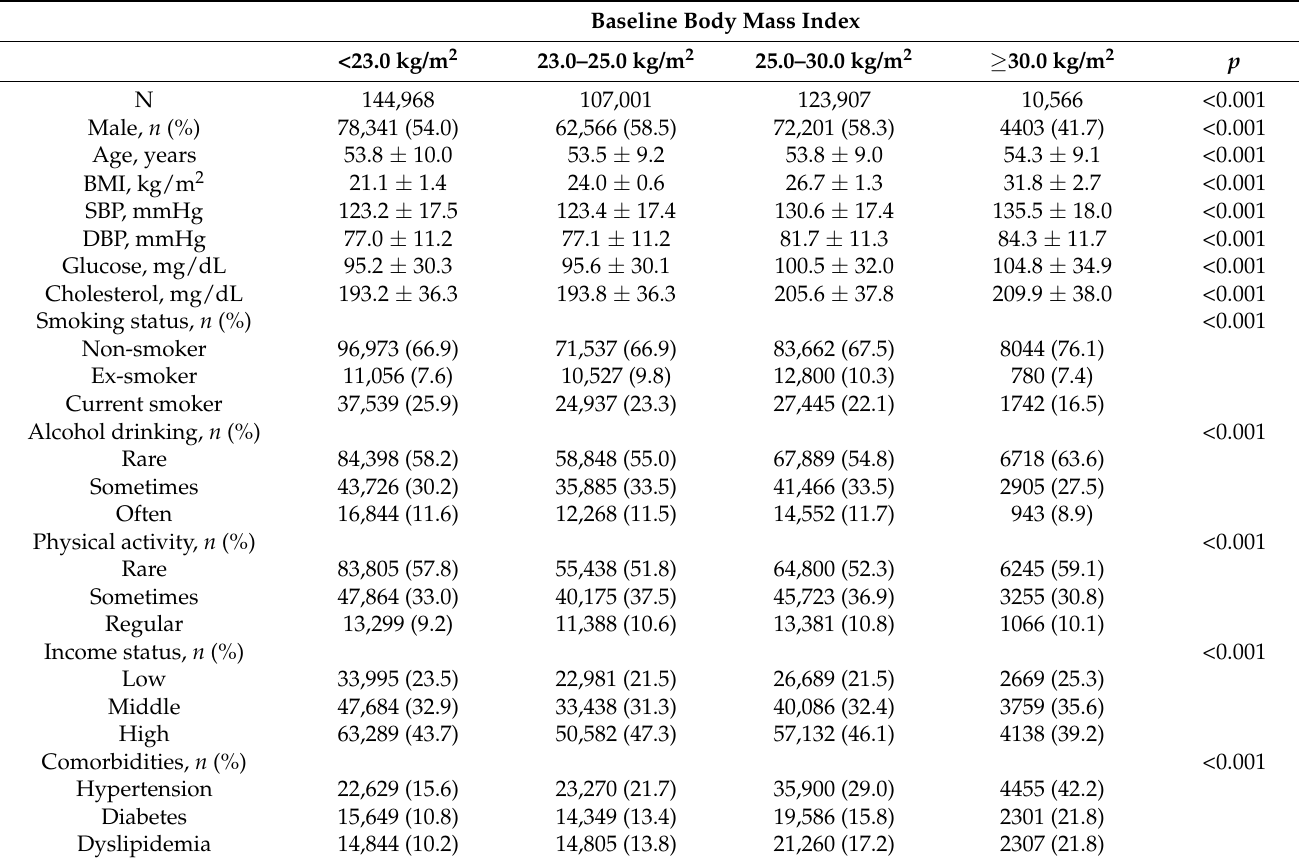
Table 1. Baseline characteristics of the study population according to baseline BMI criteria.